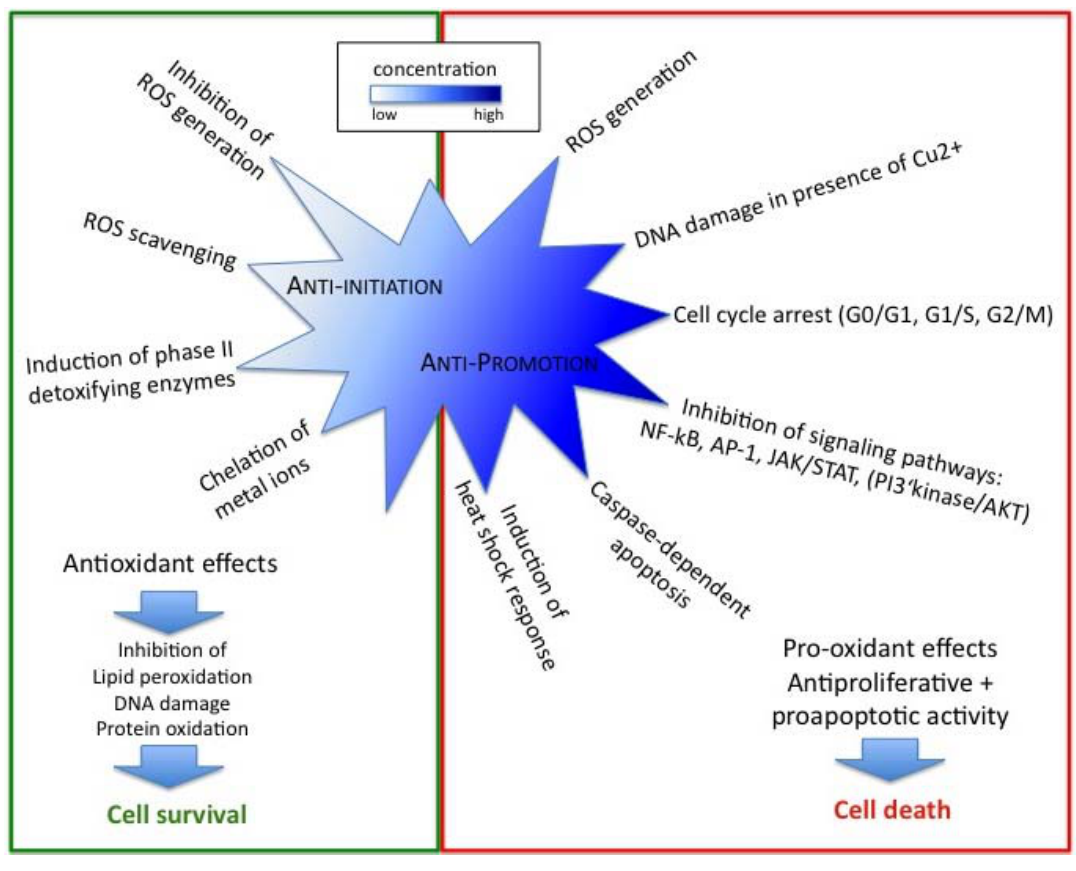
Figure 4. Overview of the chemopreventive and –therapeutic effects of resveratrol and